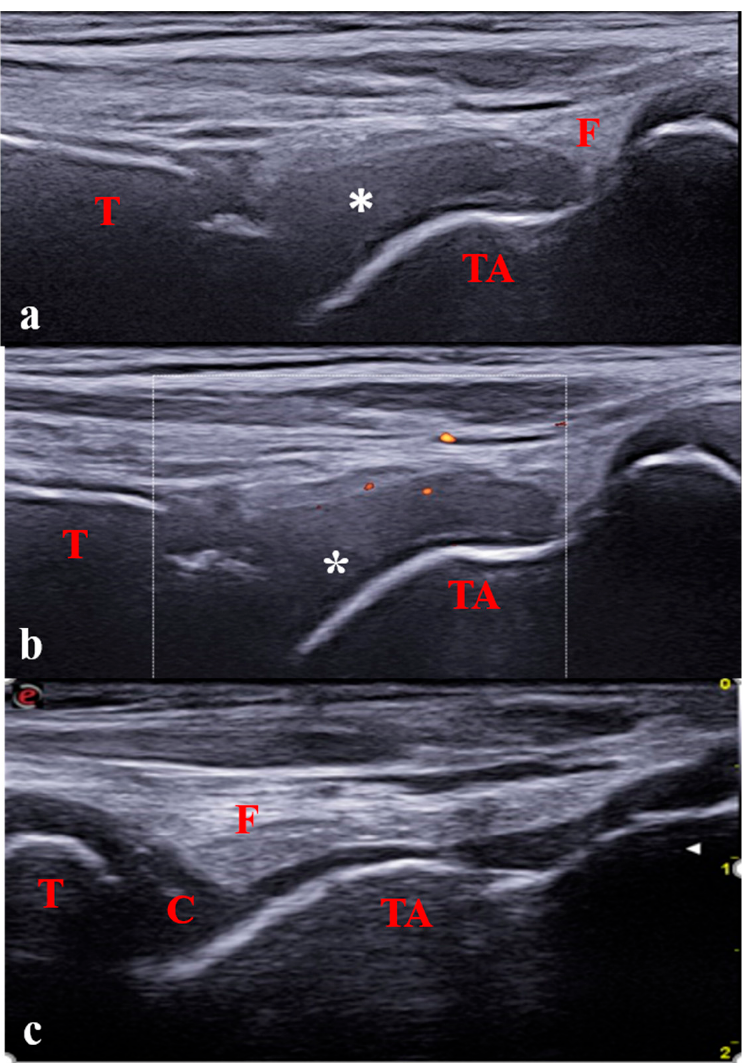
Figure 3. Longitudinal anterior scan of the tibiotalar joint in a 7-year-old with oligoarticular JIA; ( a , b ) Severe synovitis (B-mode grade 3) with minimal Doppler activity (grade 1). ( c ) Physiological aspect of the contralateral joint. C: cartilage; T: tibia; TA: talus; F: fat; * Synovitis .